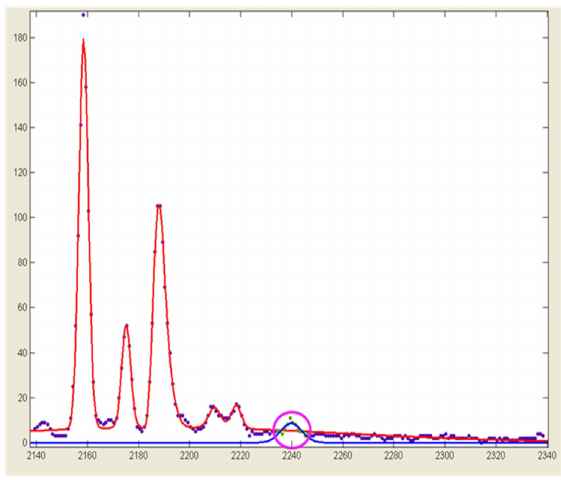
Figure 2: An example of a returned full waveform of a laser pulse passing through a tree (dots), the modelled one by fitting the summation of 8 Gaussian functions to whole waveform (red line). The circled (pink) echo was returned by the terrain and the blue curve was the result by fitting one Gaussian function to this